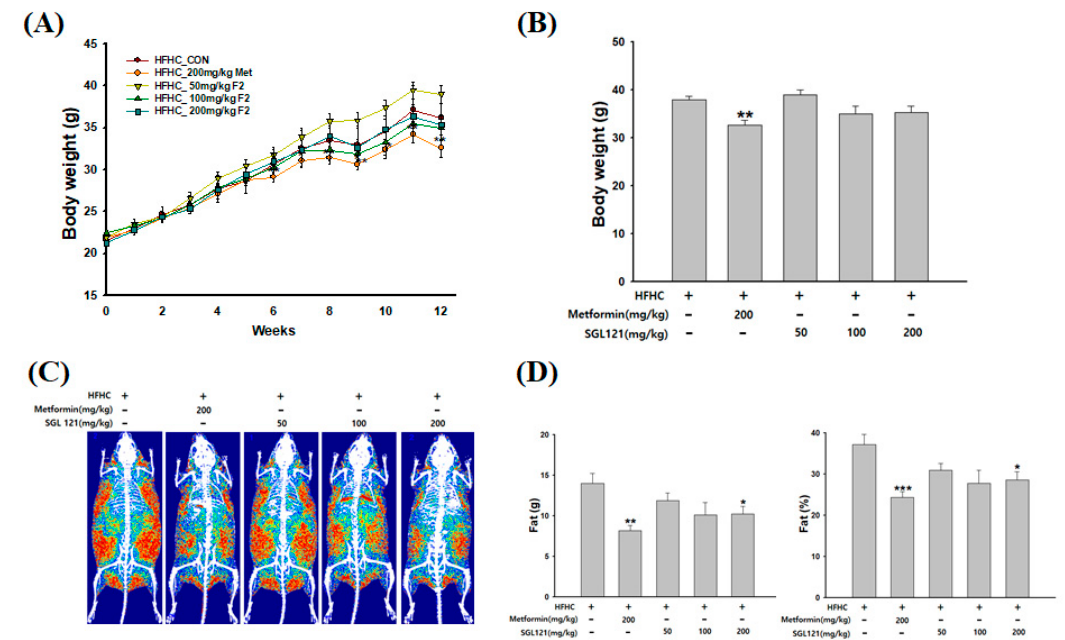
Figure 1. Effects of SGL 121(ginsenoside F2-enhanced mixture) on body weight and fat mass in nonalcoholic fatty liver disease (NAFLD)-induced mice. ( A ) Bodyweight changes, ( B ) bodyweight at week 12, ( C ) dual-energy X-ray absorptiometry (DXA) image of fat distribution, and ( D ) fat mass. Data are presented as the mean ± SE, n = 8. * p < 0.05, ** p < 0.01, and *** p < 0.001 compared to the high-fat, high-carbohydrate (HFHC) group.